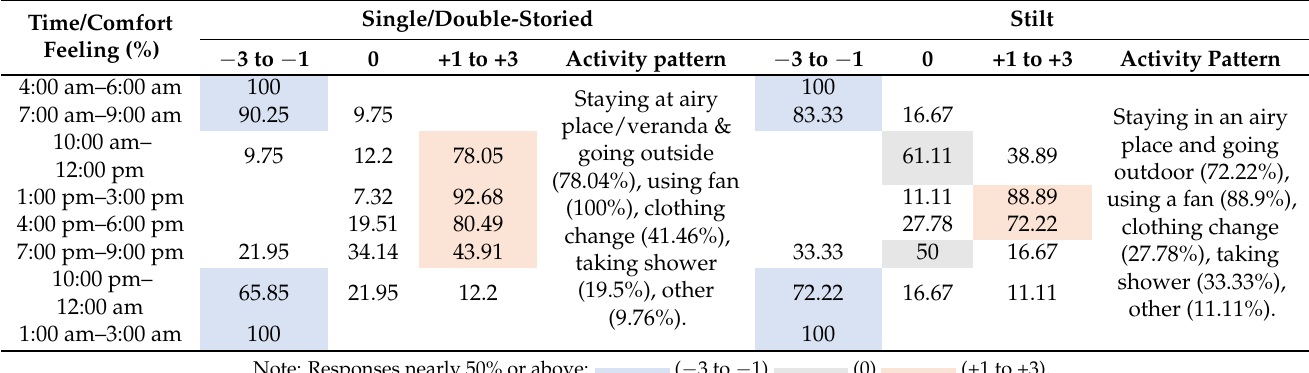
Table 8. Summary of the questionnaire survey.